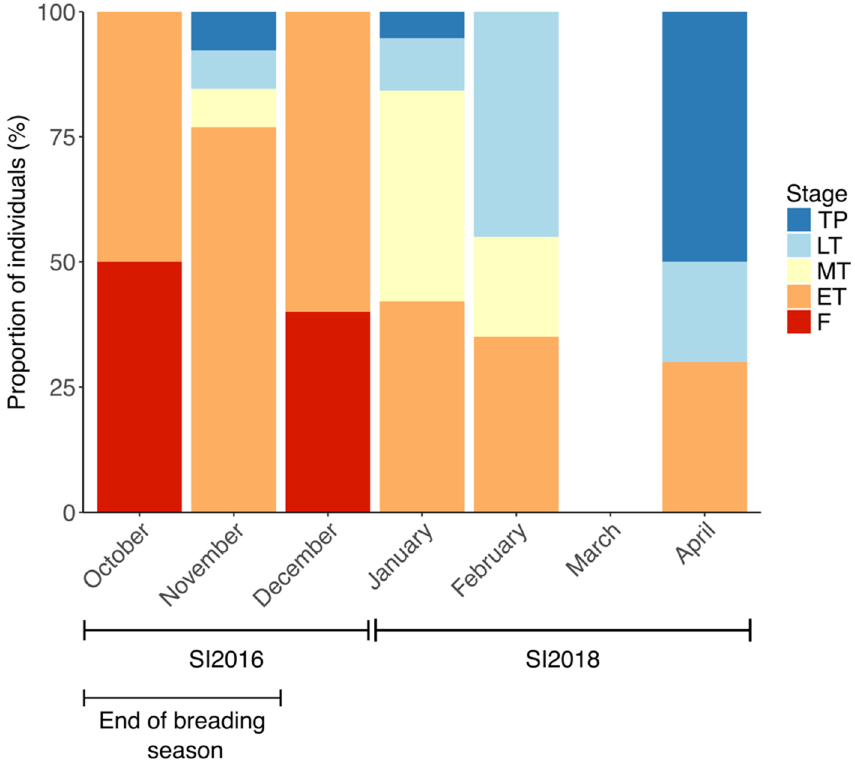
Figure 4. Proportion of SI2016 and SI2018 spotty wrasses in different sexual phases depending on month of sampling. F initial phase female, ET early transitioning fish, LT late transitioning fish, MT mid-transitioning fish, SI2016 social induction experiment 2016, SI2018 social induction experiment 2018, TP terminal phase male. Sample sizes: October n = 4, November n = 13, December n = 5, January n = 20, February n = 20, March n = 0, April n =